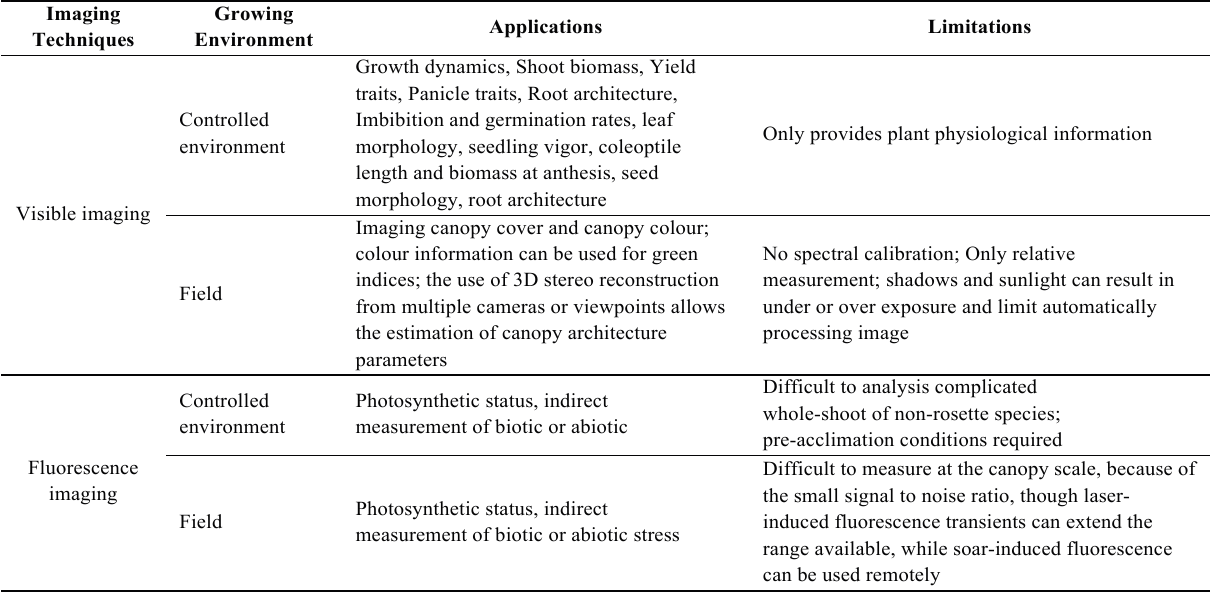
Table 2. The application and limitations of imaging techniques for plant phenotyping under different growing environments